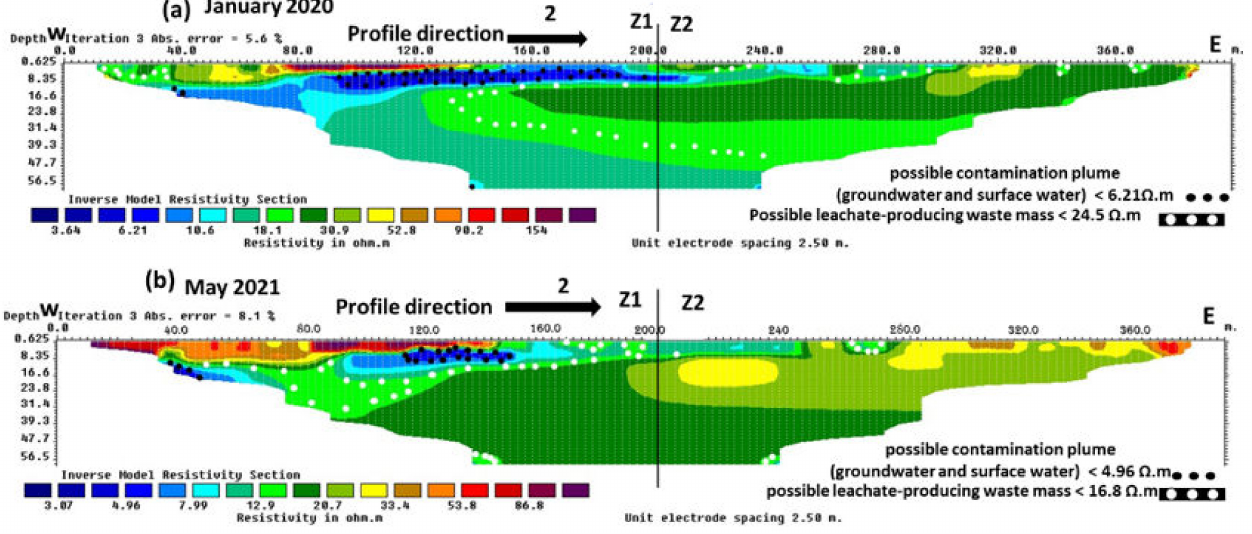
Figure 4. Electrical resistivity model of profile 2, 2020 ( a ) and 2021 ( b